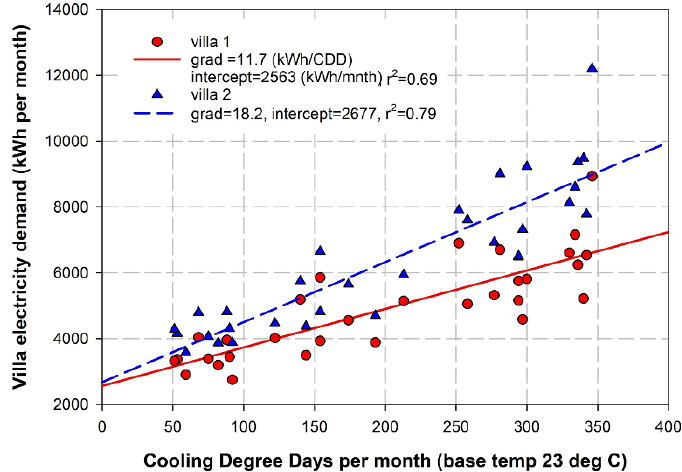
Figure 17. Monthly AC electricity demand in relation to the number of cooling degree days. The intercept (CDD = 0) shows the base, non-cooling electricity demand.